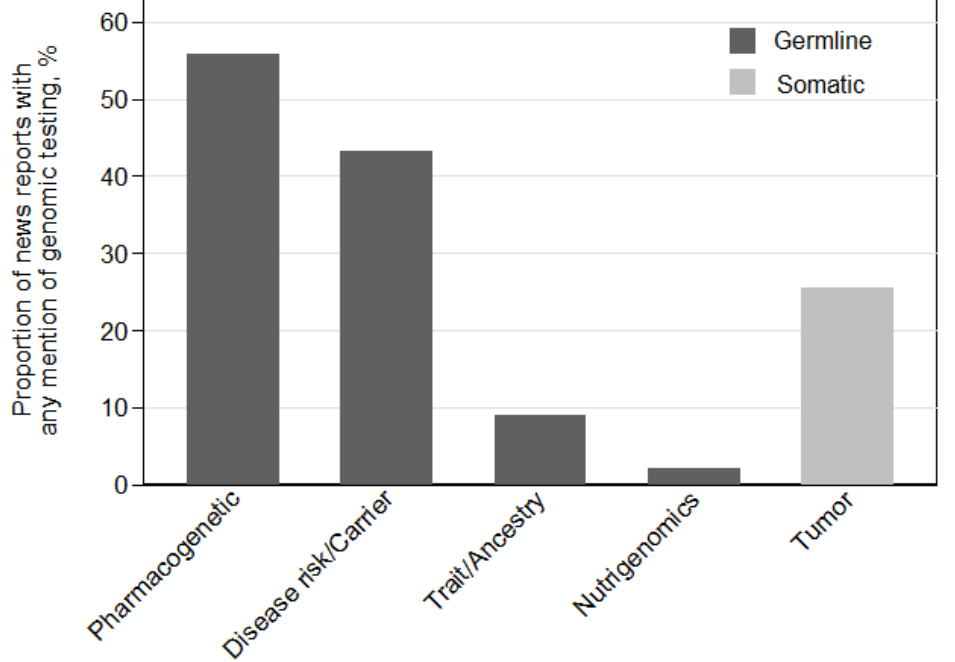
Figure 1. Types of genomic testing reported ( n = 287).